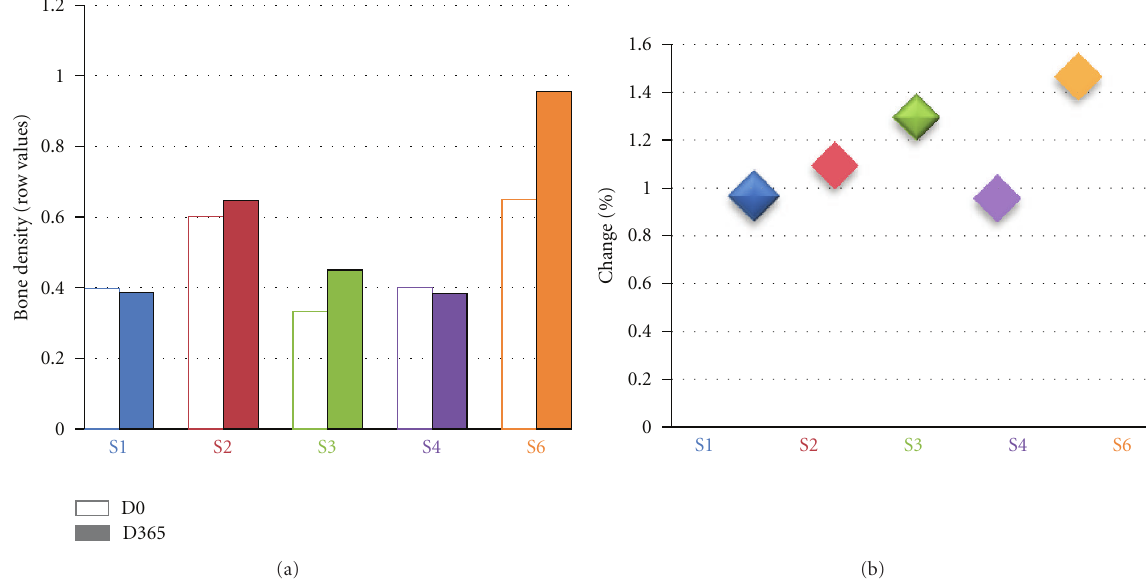
Figure 6: E ff ects of IGF1 treatment on bone density. (a): row values for bone density for each patient at D0 (empty histogram) and D365 (filled histogram). D0 (first day of treatment, before IGF administration), D90 (90 days after the first IGF1 administration), D180 (180 days after the first IGF administration, last day of IGF1 treatment), D270 (270 days after the first IGF administration), D365 (365 days after the first IGF administration). The dotted lines represent the start (D0) and the end (D180) of the treatment. Each patient is color-coded: S1: blue, S2: red, S3: green, S4: purple, and S6: orange. (b) Percentage of change between bone density at D365 versus bone density at D0. The majority of patients showed a ratio of 1, while for S3 and S6 the ratio was bigger than one showing an increase in bone mass after the